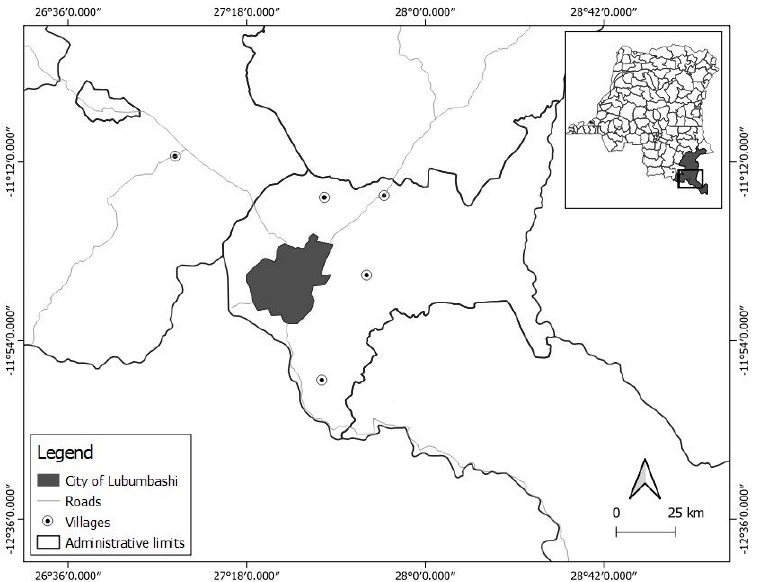
Figure 1. Location of Lubumbashi (the gray polygon) and its rural area (the white area around Lubumbashi) in Haut-Katanga province, D.R. Congo. The black dots surrounded by a halo refer to the villages covered by this study within a radius of 80 km from the city of Lubumbashi.